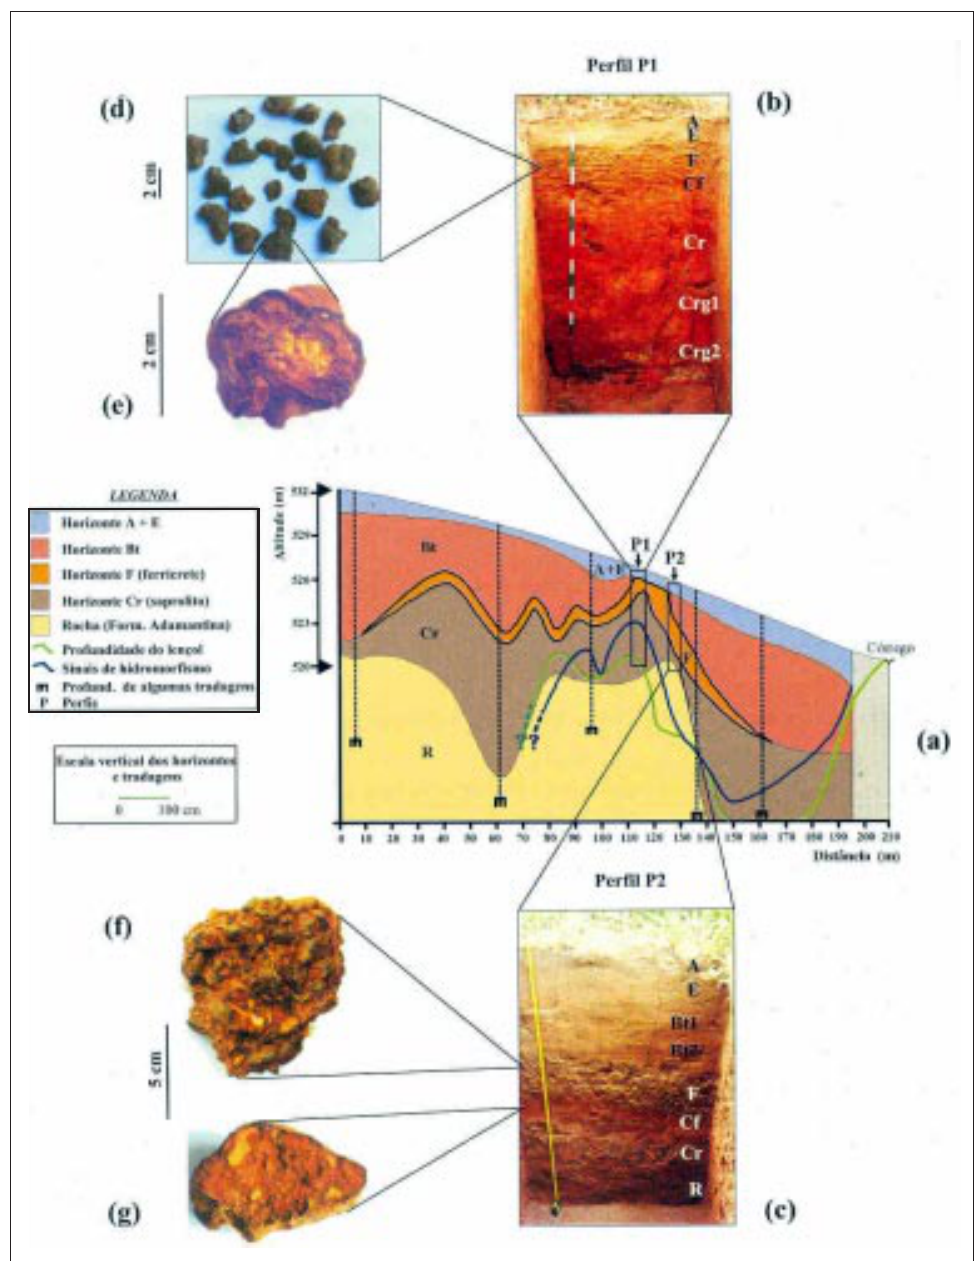
Figura 2. (a) Configuração lateral e vertical dos horizontes na seqüência estudada. Há três escalas no desenho: (a) escala horizontal (x); (b) escala vertical (x*2); (c) escala dos horizontes (x*20). (b) Perfil P1. (c) Perfil P2. (d) Nódulos predominantes dos horizontes petroplínticos na seqüência estudada. (e) Detalhe do interior dos nódulos, evidenciando o córtex milimétrico mais avermelhado em relação ao seu interior, bem como tons amarelados dispersos na sua matriz. (f) Glébula “ruiniforme” do horizonte petroplíntico (perfil P2). (g) Plintita do horizonte Cr do Perfil